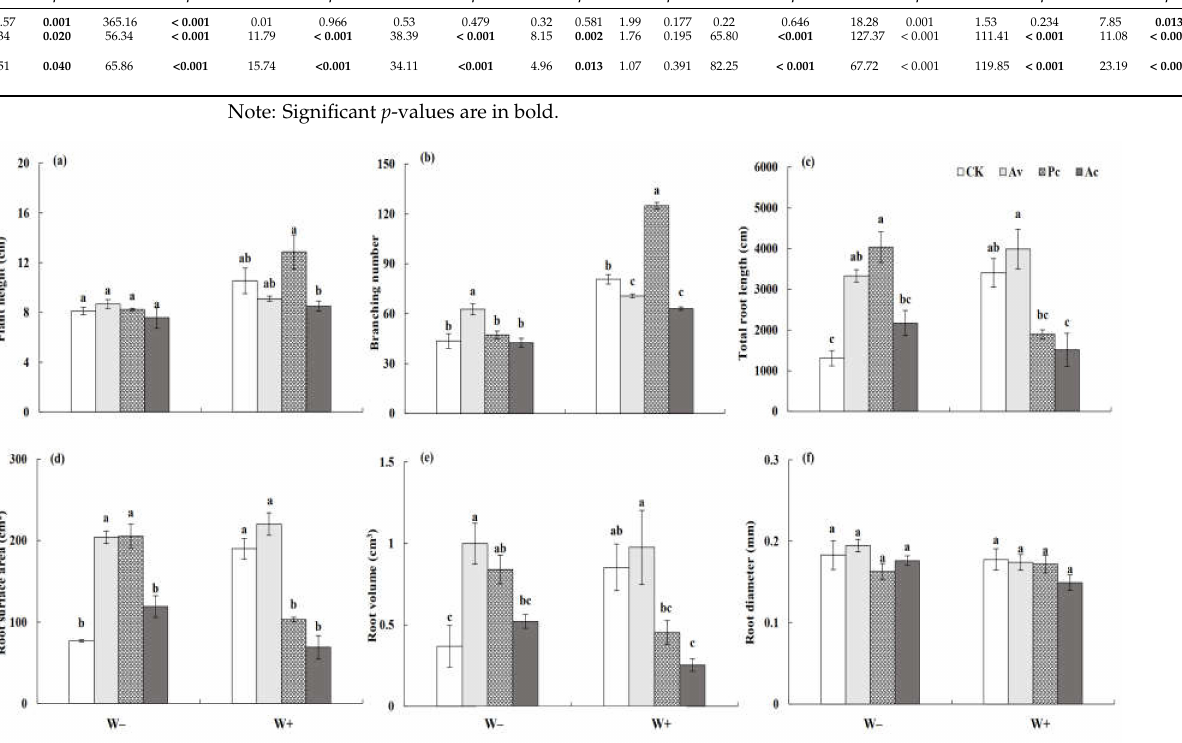
Figure 10. Effects of dark septate endophyte (DSE) on the shoot and root morphological traits of Artemisia ordosica seedlings under drought stress. Different letters above the error bars indicate a significant difference at p < 0.05. Note: ( a ), plant height, ( b ), branching number, ( c ) total root length, ( d ), root surface area, ( e ), root volume, ( f ), root diameter. W − , drought treatment. W+, well-watered treatment. CK, non-DSE inoculated control. Ac, Pc, and Av, plants inoculated with Alternaria chartarum , Paraphoma chrysanthemicola , and Acrocalymma vagum